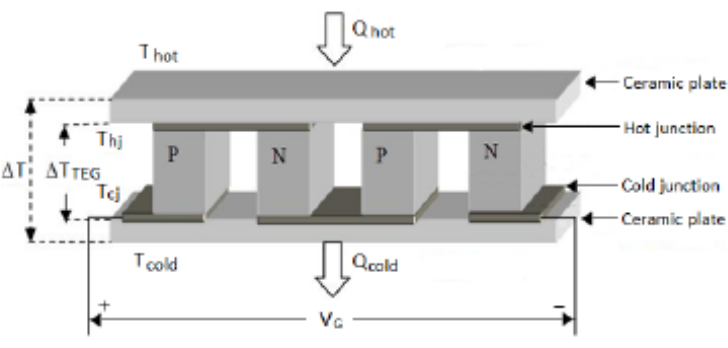
Figure 13. Seedbeck Effect Phenomena of thermoelectric generators (TEGs)